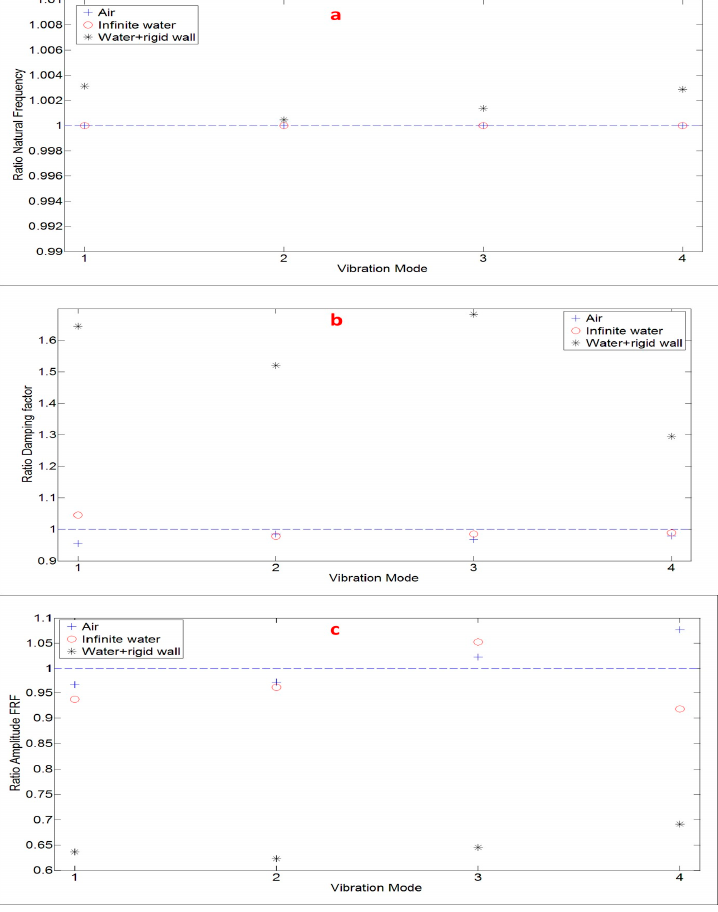
Figure 18. Comparison modal parameters for the four analyzed modes. Ratio modal parameter PZTs: ( a ) Natural Frequency; ( b ) Damping Factor; and ( c ) Amplitude